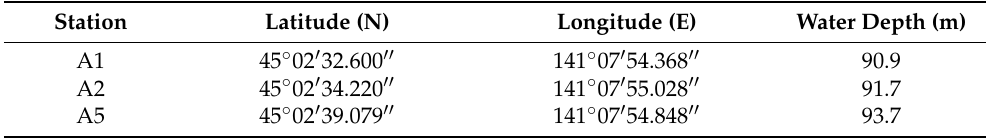
Table 1. The position and bottom depth of the sampling stations (A1, A2, and A5).